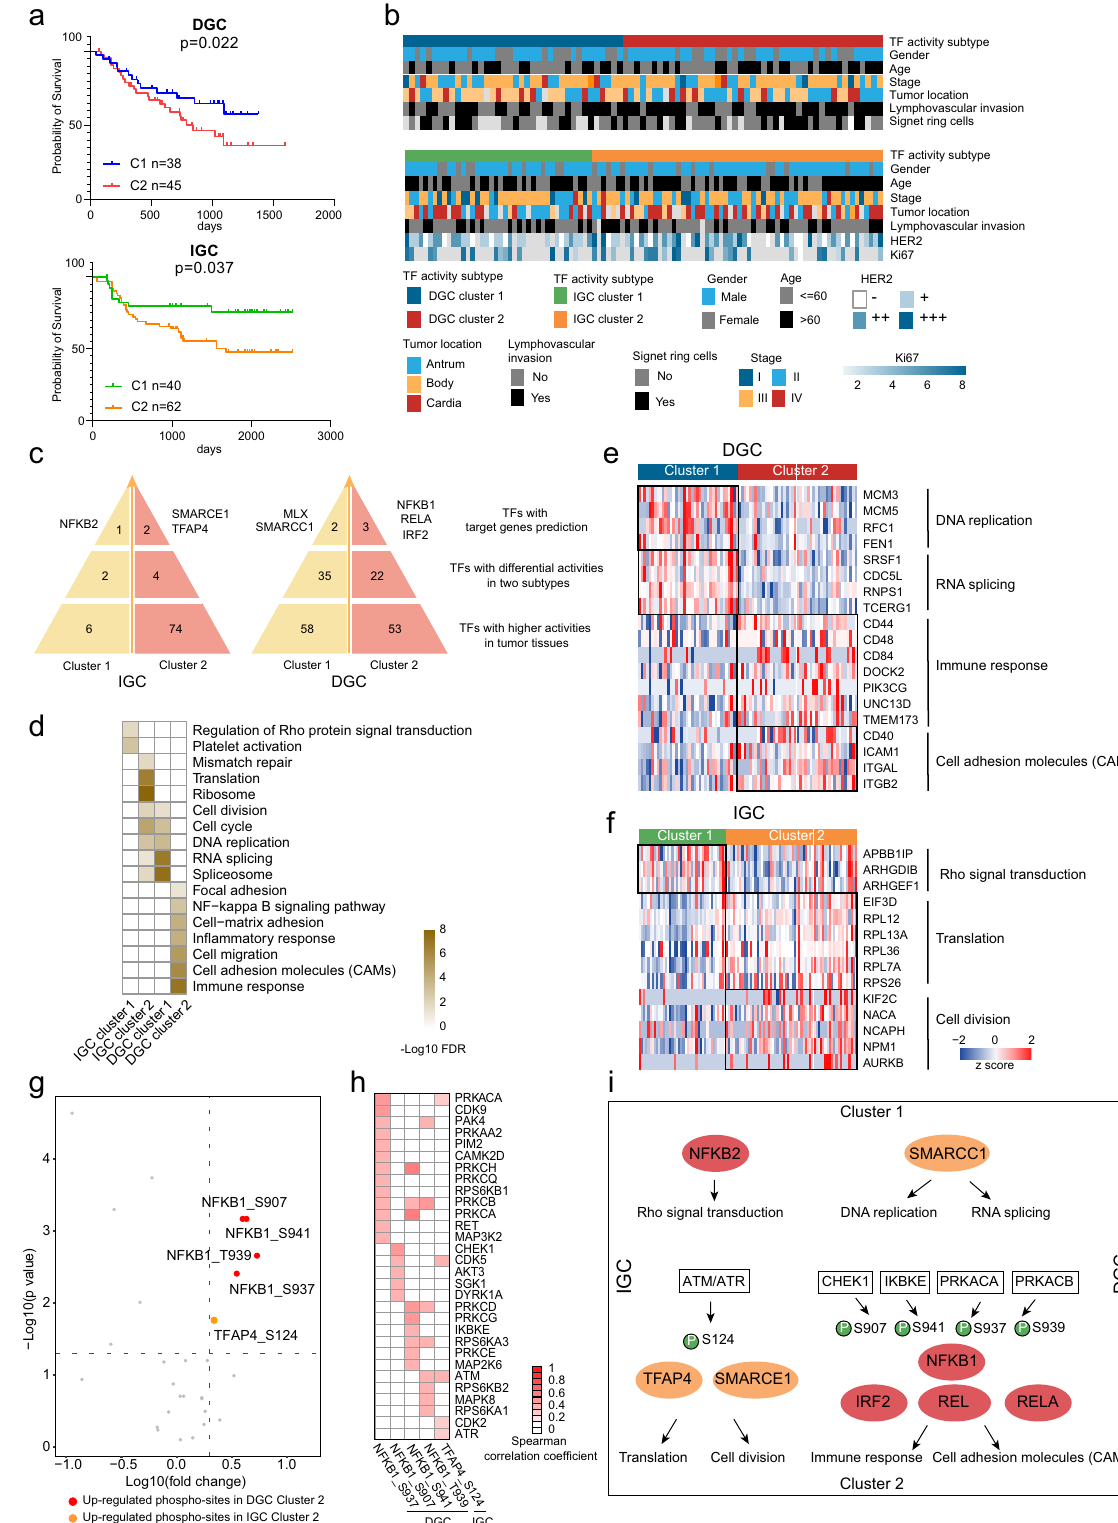
phospho-proteomic subtypes and three IGC phospho-proteomic subtypes. We designated the subtypes as DGC phospho-proteomic cluster 1 ( n = 27), DGC phospho-proteomic cluster 2 ( n =37), and DGC phospho-proteomic cluster 3 ( n =16) in DGC; and IGC phospho- proteomiccluster 1 ( n =27), IGC phospho-proteomic cluster 2 ( n = 26), and IGC phospho-proteomic cluster 3 ( n =30) in IGC, respectively